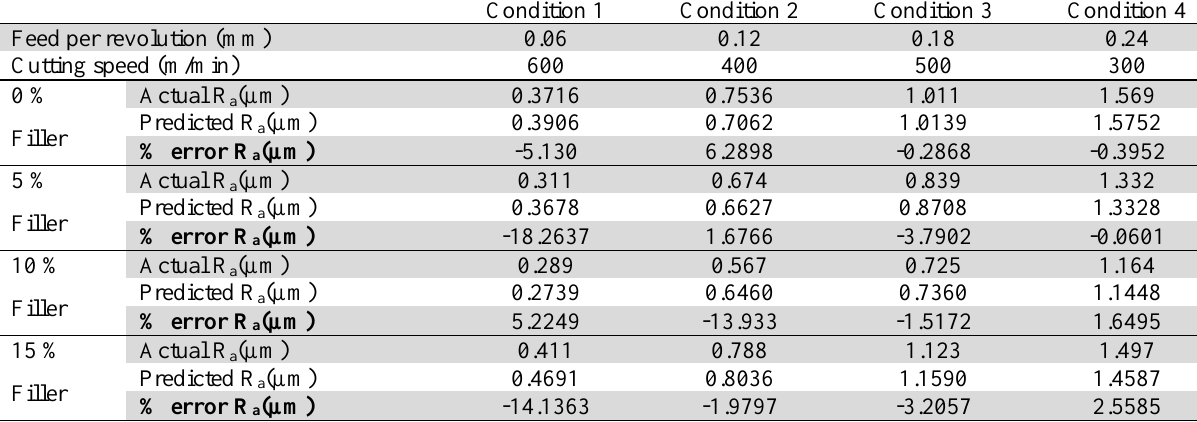
Testing the network with new samples